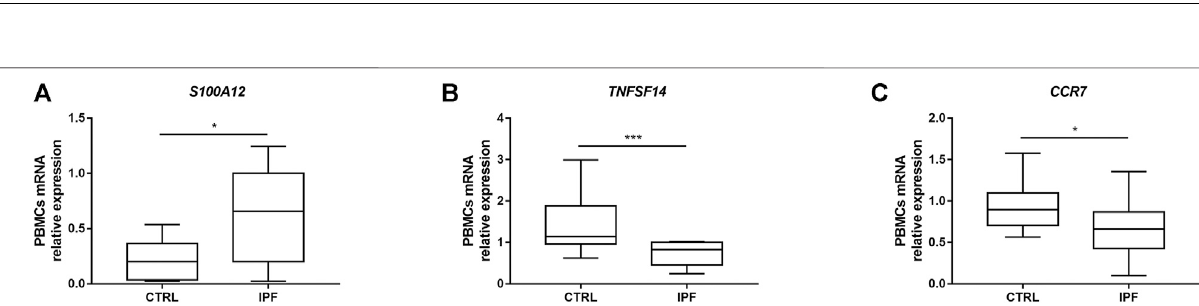
Frontiers in Molecular Biosciences |